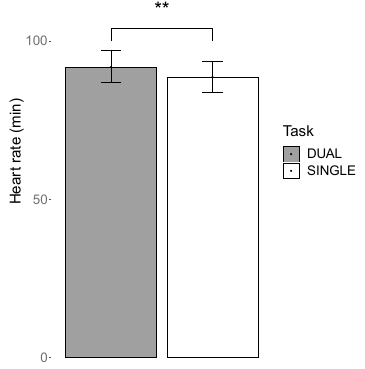
Figure 9. Mean heart rate as a function of task difficulty. ** p < 0.01.